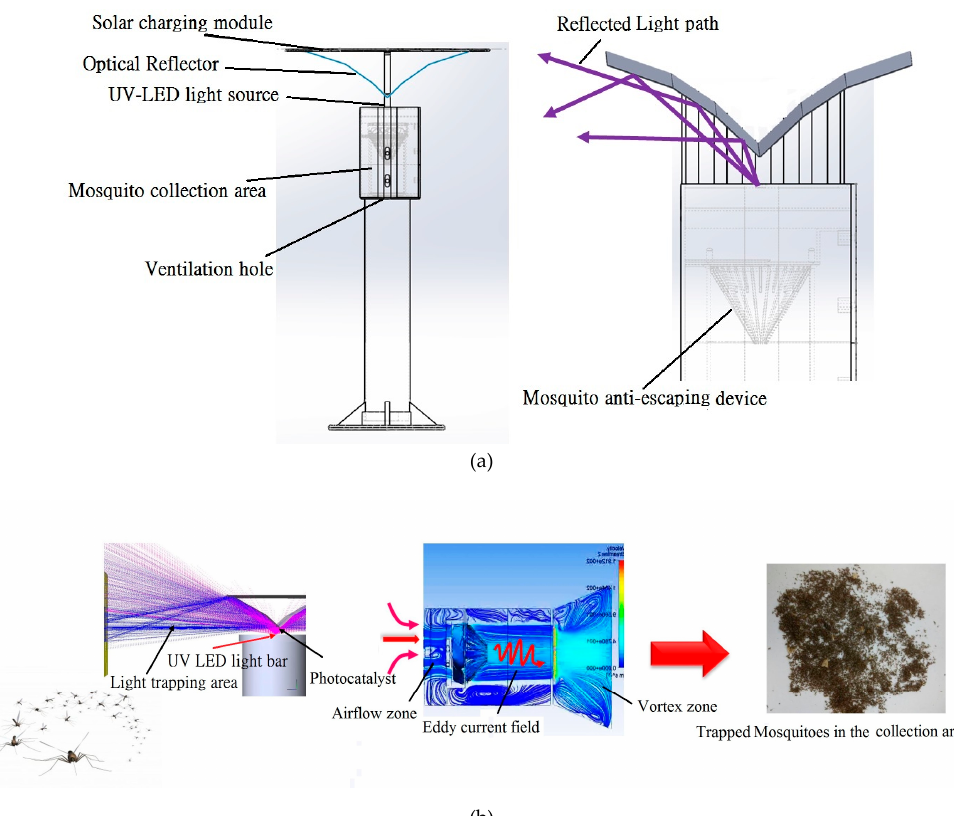
Figure 2. ( a ) Proposed mosquito trapping system; ( b ) Workflow of proposed mosquito trapping